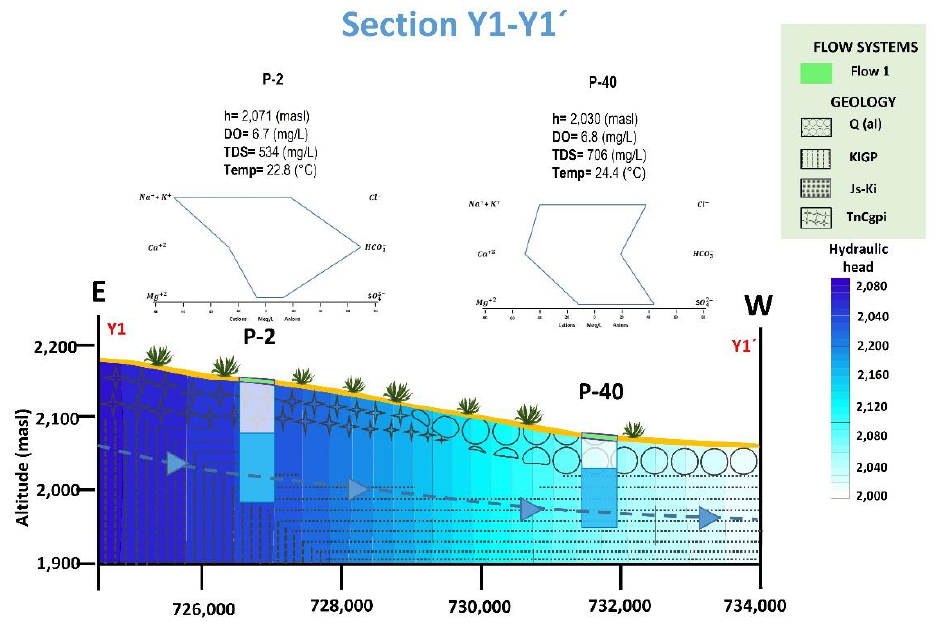
Figure 8. Hydrogeological cross section Y1–Y1′.